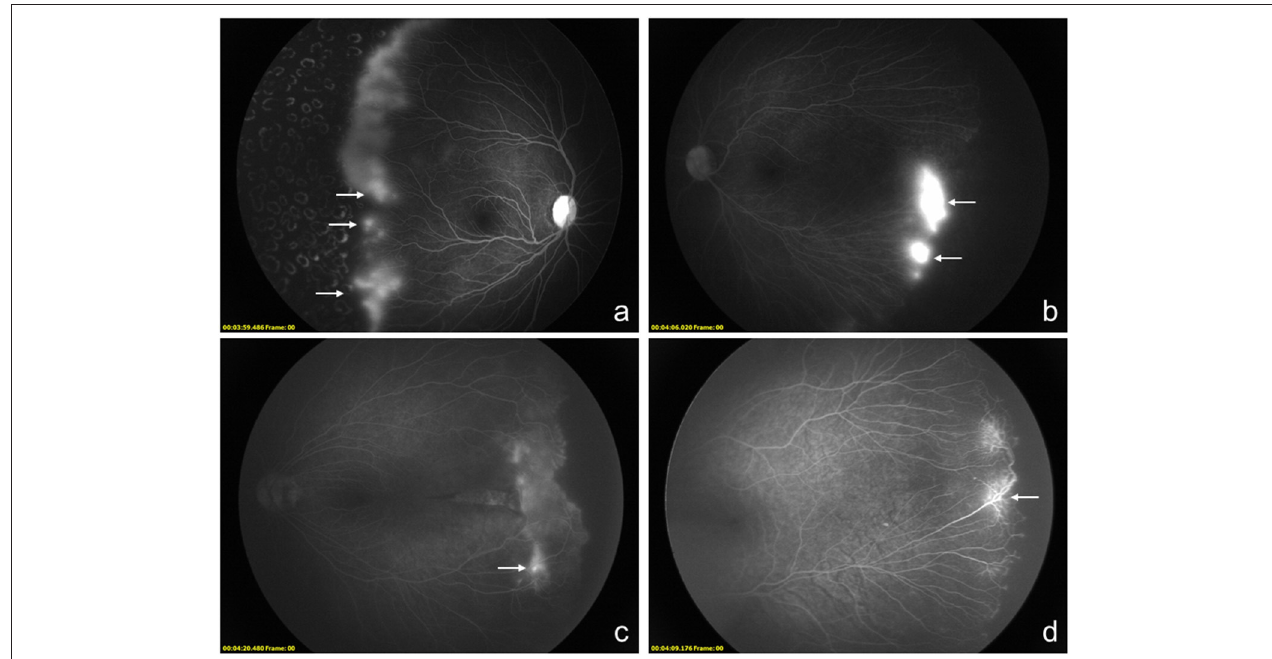
FIGURE 1 | Montage of fluorescein angiography images of 4 different infants who received anti-VEGF agents as the primary treatment with the diagnosis of retinopathy of prematurity (ROP). (a–d) , Different types of hyperfluorescence lesions of the peripheral retina can be observed and categorized. The vascular leakage can be observed at (a,b) . The hyperfluorescence defined as fibrosis membrane is shown in (c). As another kind of hyperfluorescence lesion, vascular abnormality is shown in (d)